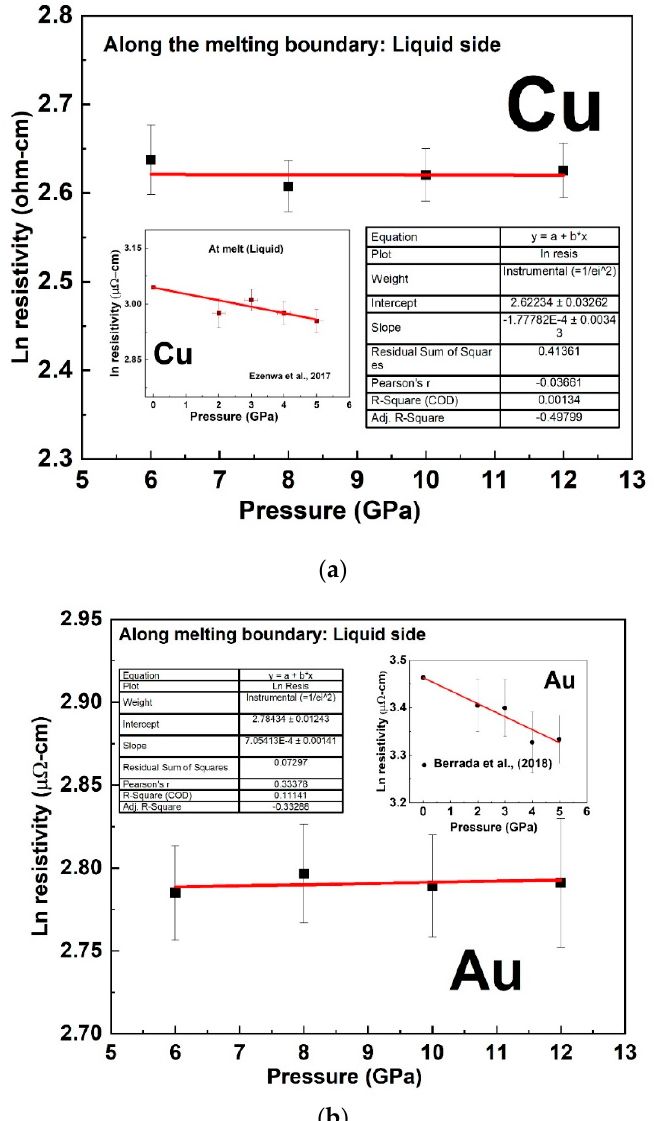
Figure 7. The natural logarithm of the electrical resistivity of Cu ( a ) and Au ( b ) along the pressure- dependent melting boundary. The fit line has a slope of ( − 1.77782 × 10 -4 ± 0.00344) GPa − 1 for Cu and (7.05413 × 10 -4 ± 0.00141) GPa − 1 for Au. The inset lower pressure data are from [10,12] for Cu and Au respectively.